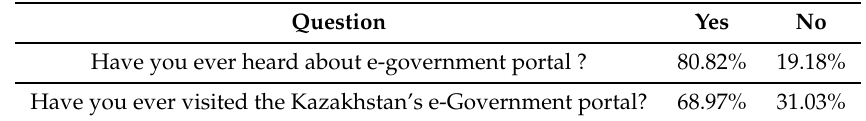
Table 5. Actual use.